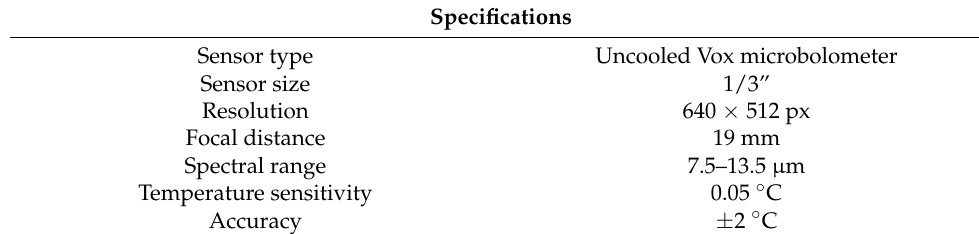
Table 2. Thermal dual sensor specifications.